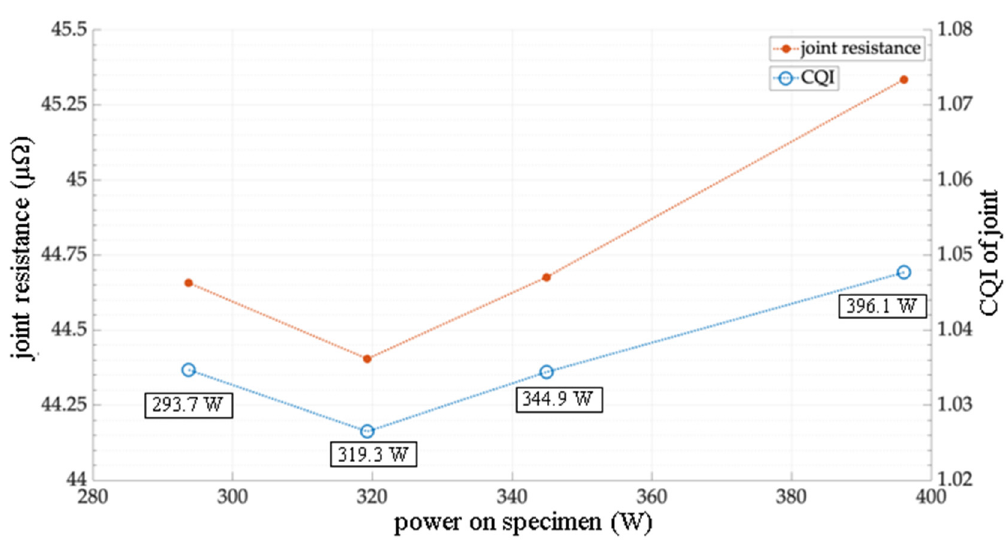
Figure 8. Resistance and CQI of central weld joints with varying laser powers and hence intermetallic phases ( v f = 100 mm/s, A = 0.2 mm, f = 1000 Hz).